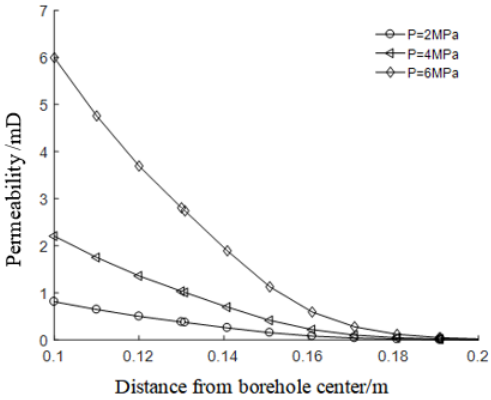
Figure 4. The change in coal rock permeability around the borehole under different gas